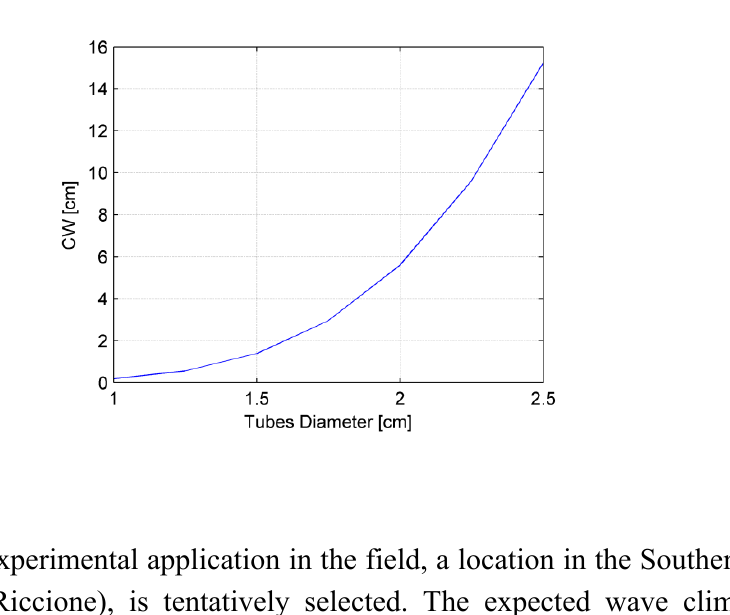
Figure 23. CW increase with tubes diameter up to resonant conditions (valve and pipe diameter are equal).